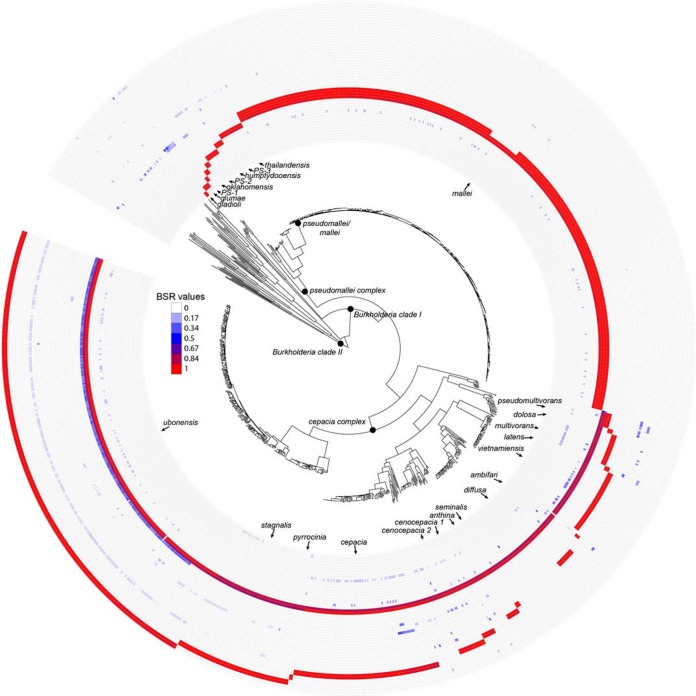
A core genome single-nucleotide-polymorphism (SNP) phylogeny associated with a heat map of markers unique to specific clades. The core genome phylogeny was inferred with RAxML (31) on a concatenated SNP alignment produced by aligning 1,130 genomes against the finished genome of B. pseudomallei K96243 (19), using NUCmer (20) in conjunction with NASP (http://tgennorth.github.io/NASPtgennorth.github.io/NASP). Coding regions unique to specific clades were aligned against all genomes with LS-BSR (22), and the heat map was visualized with the Interactive Tree of Life (42). The heat map demonstrates the distribution of identified markers against all genomes screened in this study.